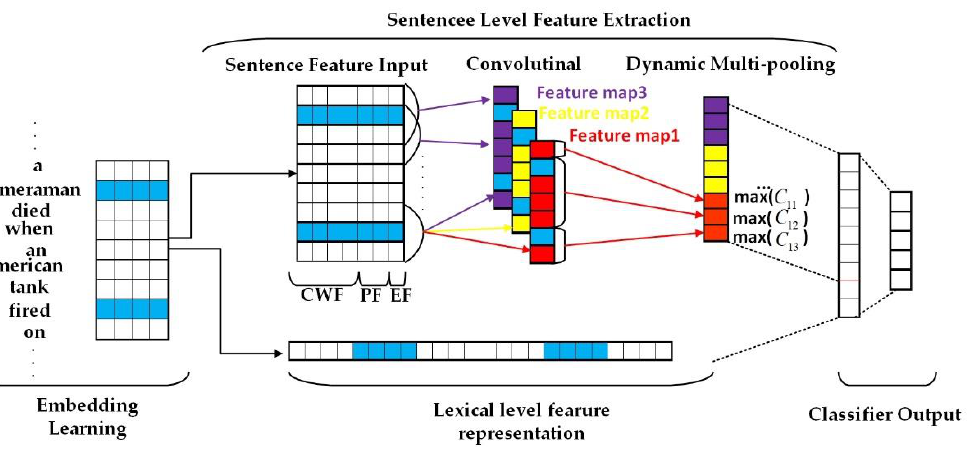
Figure 5. The DMCNN uses dynamic multi-pooling convolution to capture different parts of a sentence, thereby retaining more critical information [71].